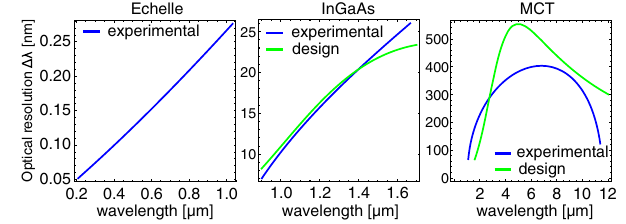
FIG. 13. Features the absolute instrument spectral resolution Δ λ , individually obtained for each spectrometer arm. Since the theoretical angular dispersion for the commercial echelle spectrometer is not available, only the experimental curve is presented here.